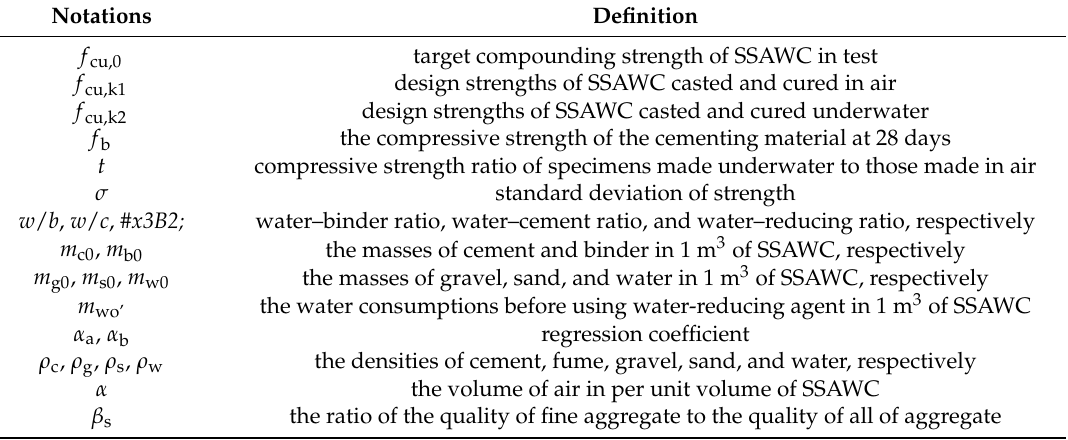
Table 9. List of